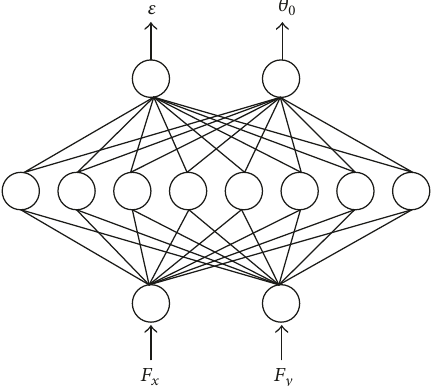
Figure 4: Neural network model mapping the function between the force and journal position.